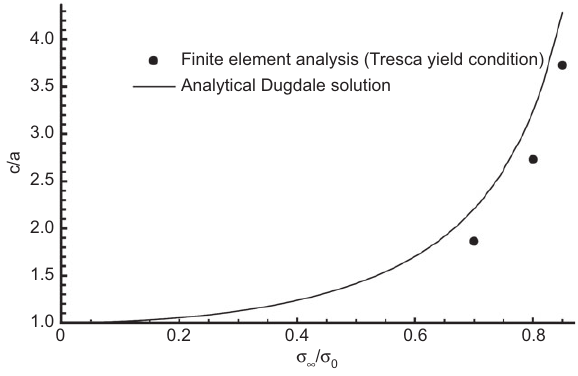
Figure 2 Comparison of normalized plastic zone length to normalized load between numerical and analytical